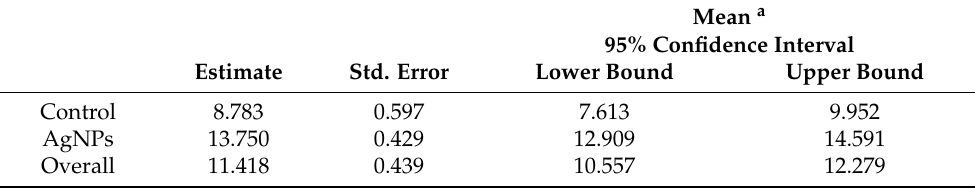
Table 9. Mean survival time (Groups 1a and